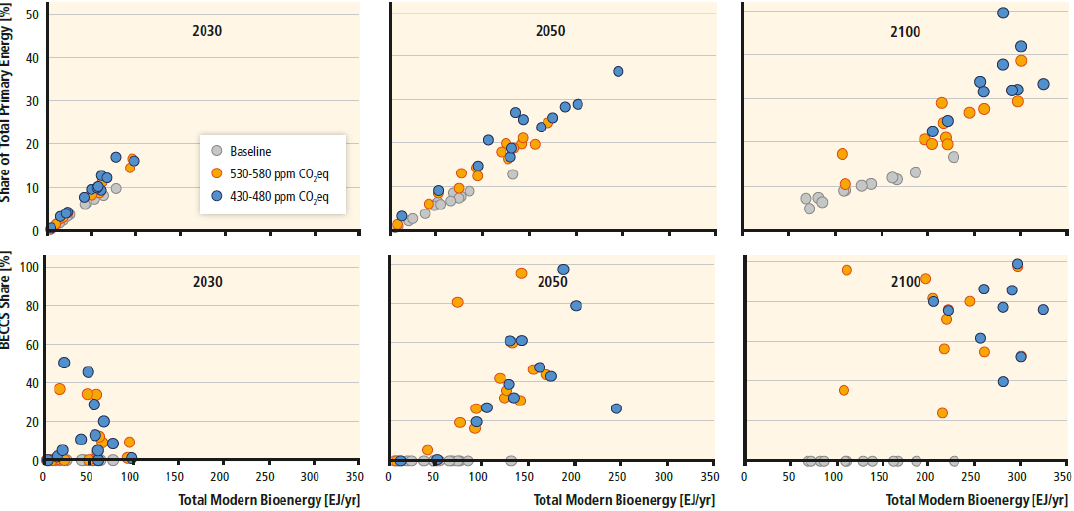
Figure 4. Global deployment of biomass for a range of global GHG mitigation scenarios (as assessed by [2]).